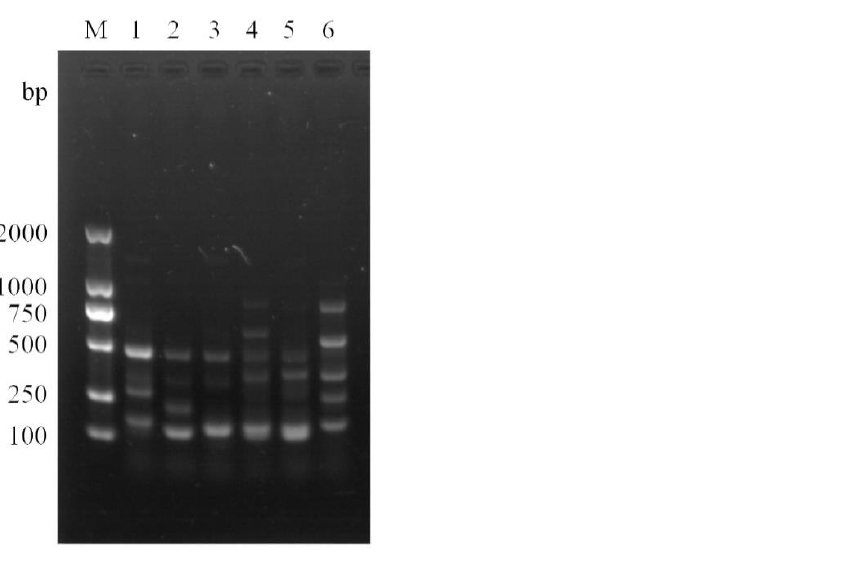
Figure 1. Gel electrophoresis images of different S. cerevisiae strains. M, D2000 DNA Ladder (Solar-bio Life Science); 1, Safoeno NDA 21 (Fermentis); 2, Enartis Ferm ES488 (Enartis); 3, Enartis Ferm Red Vintage (Enartis); 4, Enartis Ferm AMR-1 (Enartis); 5, Zymaflore FX10 (Laffort); 6, L59.